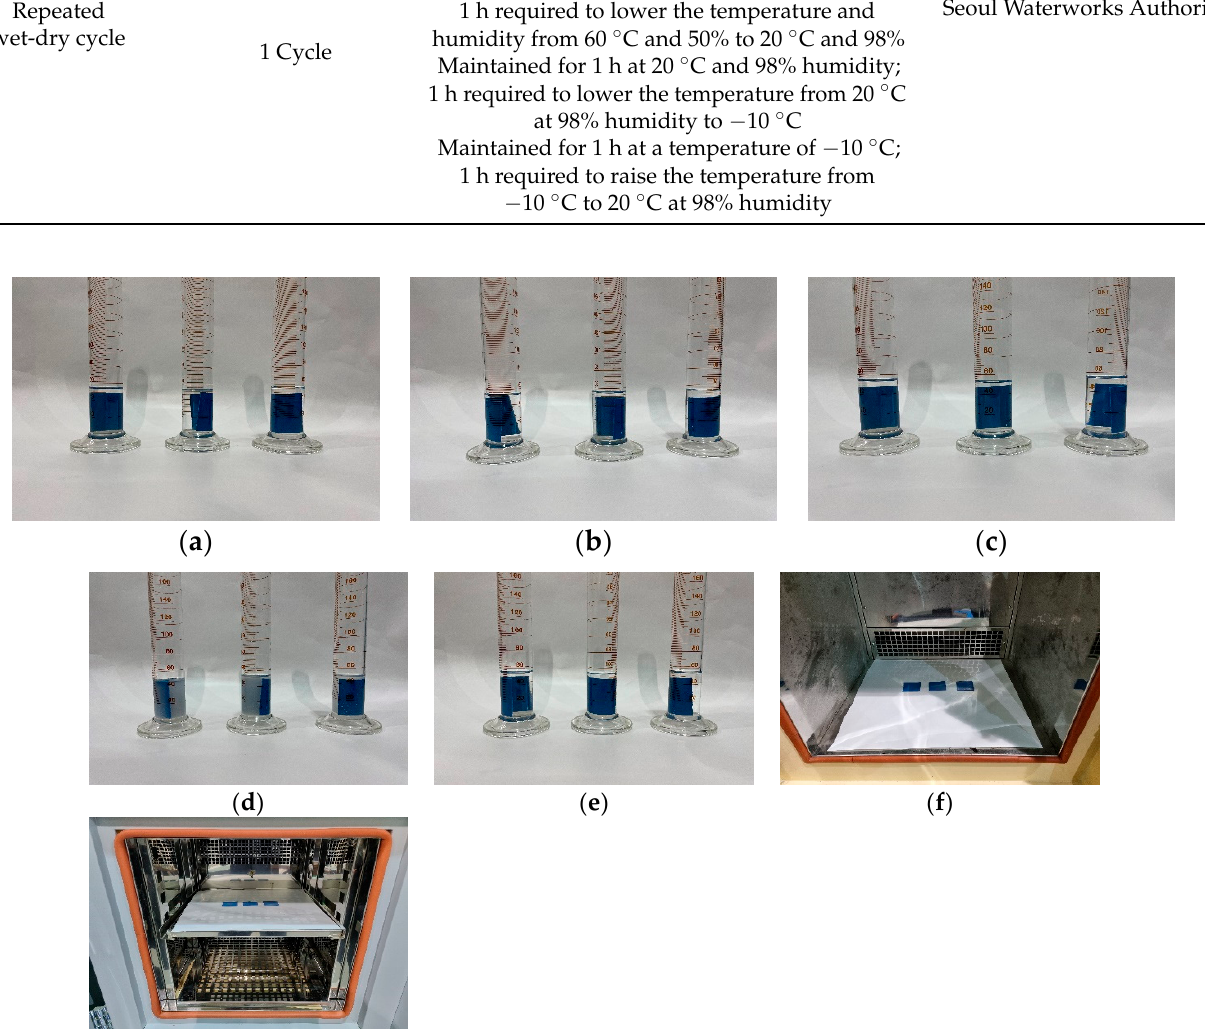
Table 7. The swelling rate test results under deterioration conditions according to the superabsor- bent polymer content.